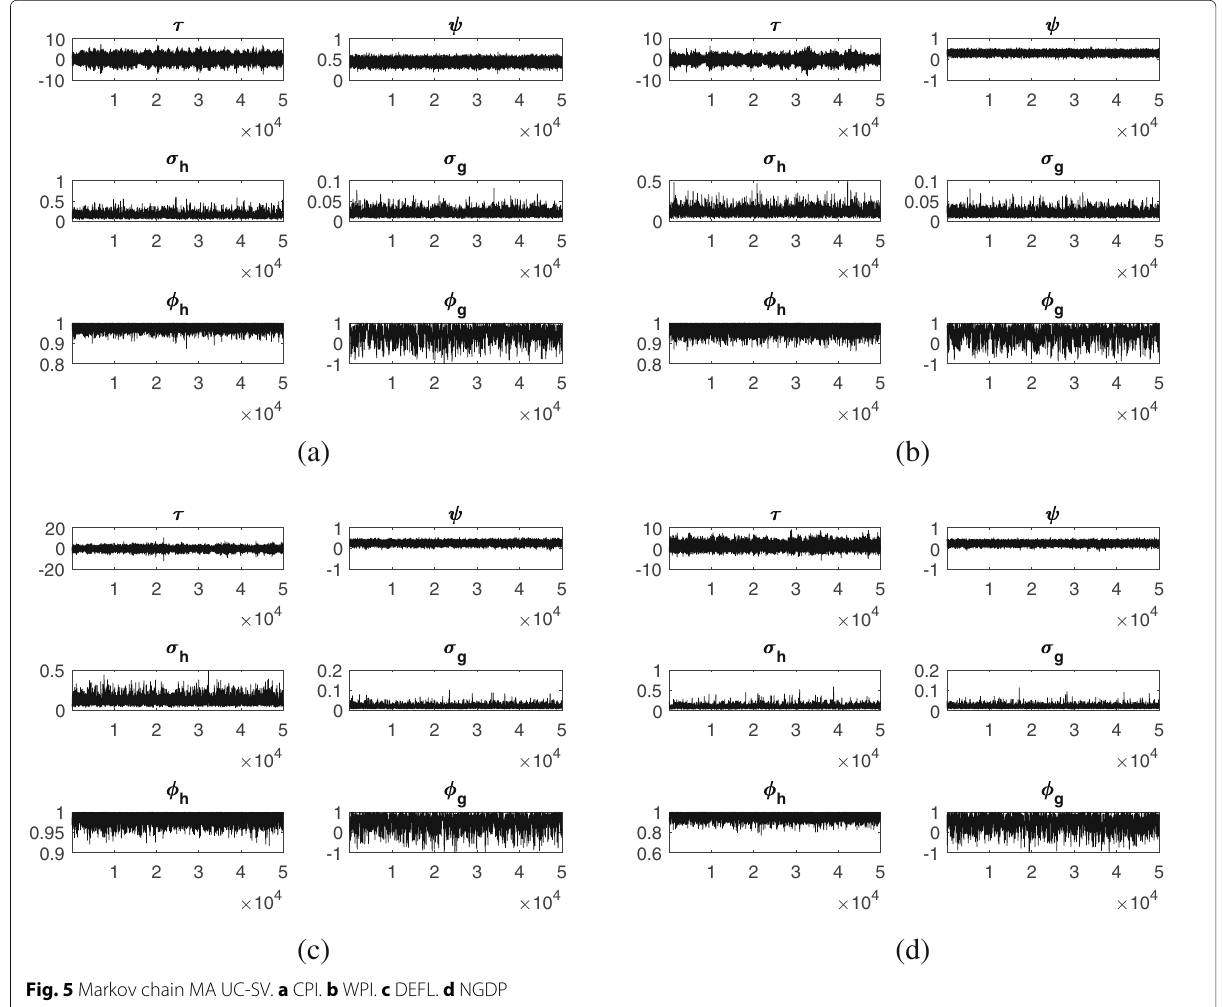
Fig. 5 Markov chain MA UC-SV. a CPI. b WPI. c DEFL. d